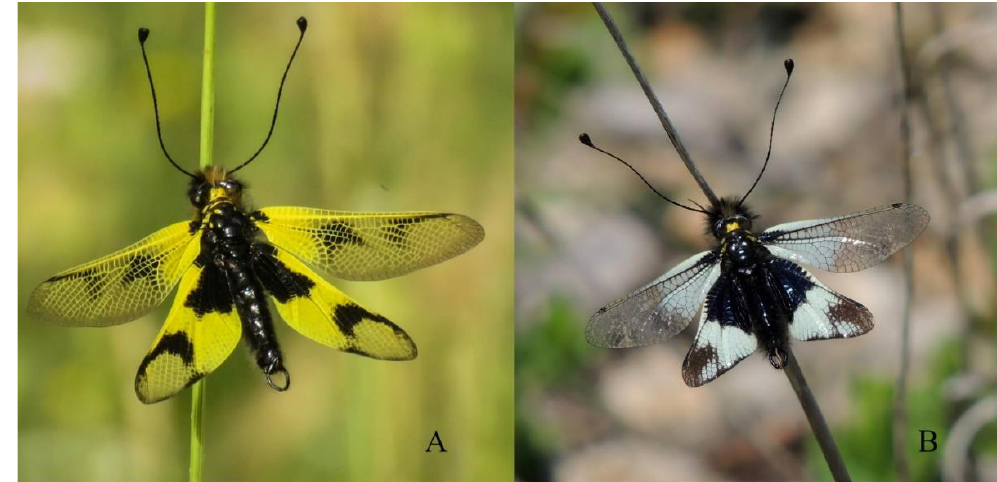
Figure 1. A – Libelloides macaronius (Scopoli, 1763) (photo by D. Petrović, 2021); B – Libelloides lacteus (Brullé, 1832) (photo by I. Medenica, 2017).